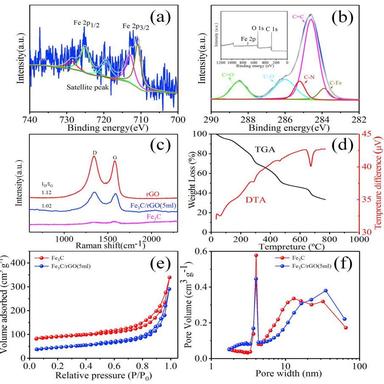
High-resolution a) Fe 2p and b) C 1s XPS spectra of Fe3C/rGO(5 ml) (inset in b: XPS survey spectrum). c) Raman spectra of rGO, Fe3C and Fe3C/rGO(5 ml) (λ ¼ 633 nm). d) TG-DTA patterns of Fe3C/rGO(5 ml). e) N2 adsorption–desorption isotherms and f) pore size distribution of Fe3C and Fe3C/rGO(5 ml).